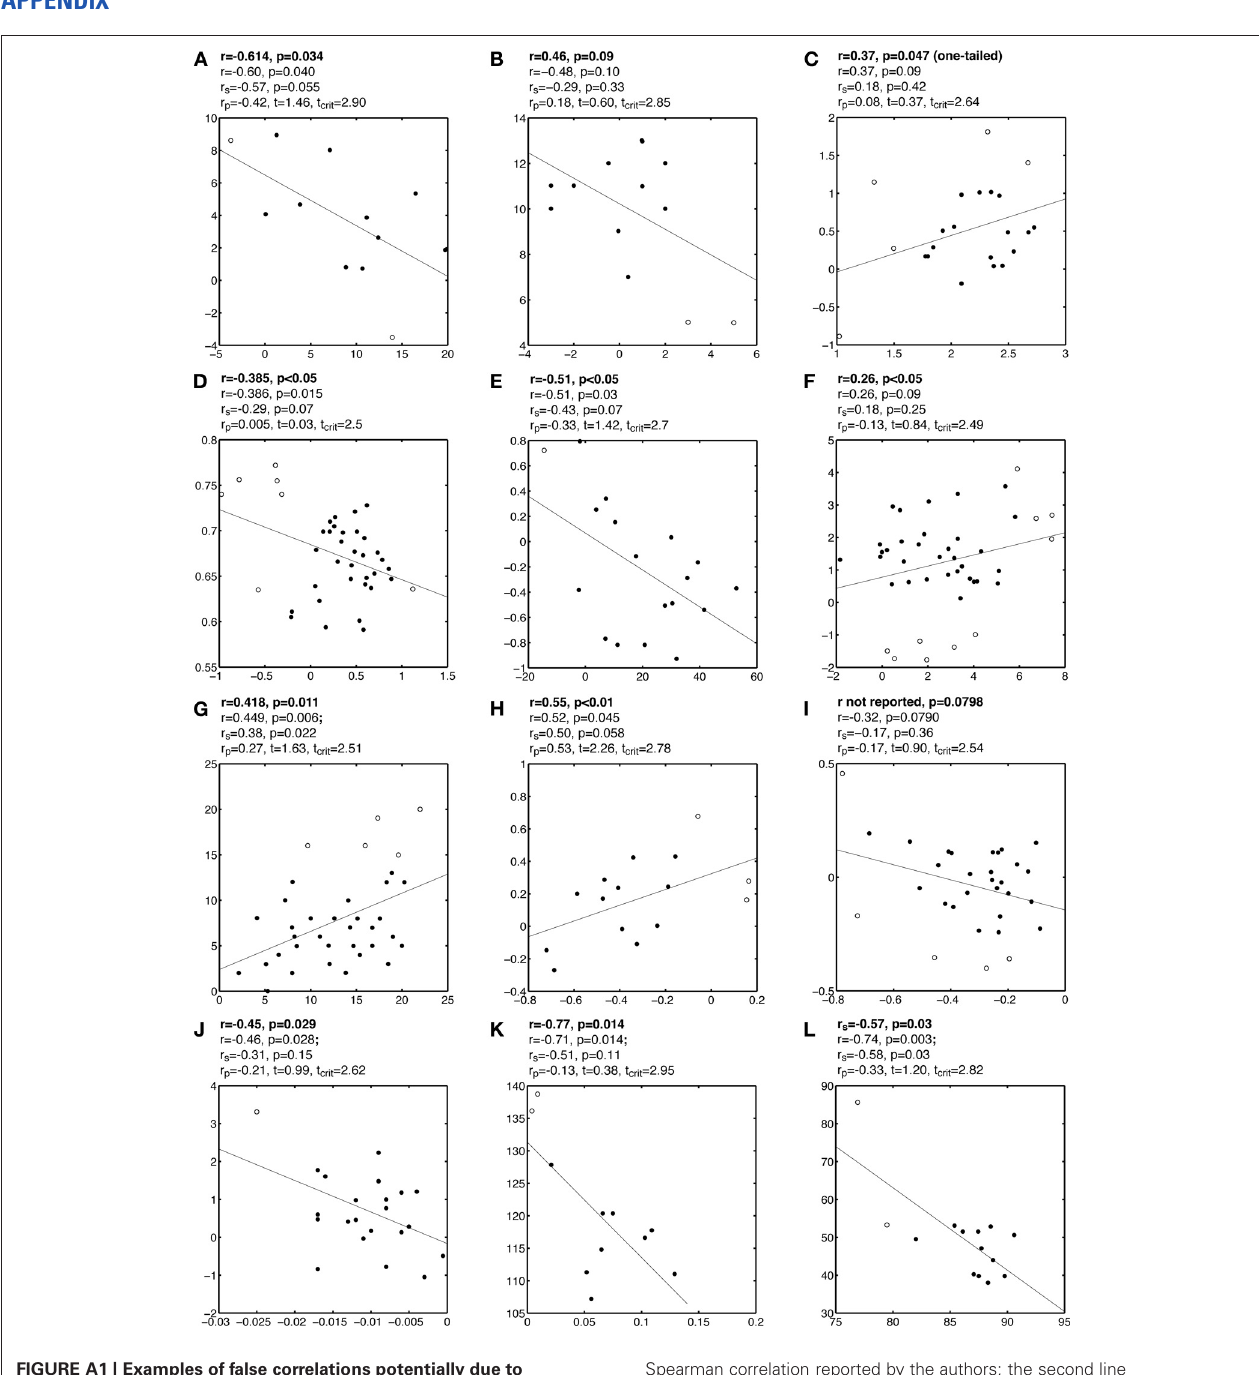
FIGURE A1 | Examples of false correlations potentially due to outliers. Each subplot contains a regression line and a scatterplot with outliers marked by circles and other points marked by disks. Analyses are reported above each subplot: the first line contains the Pearson or